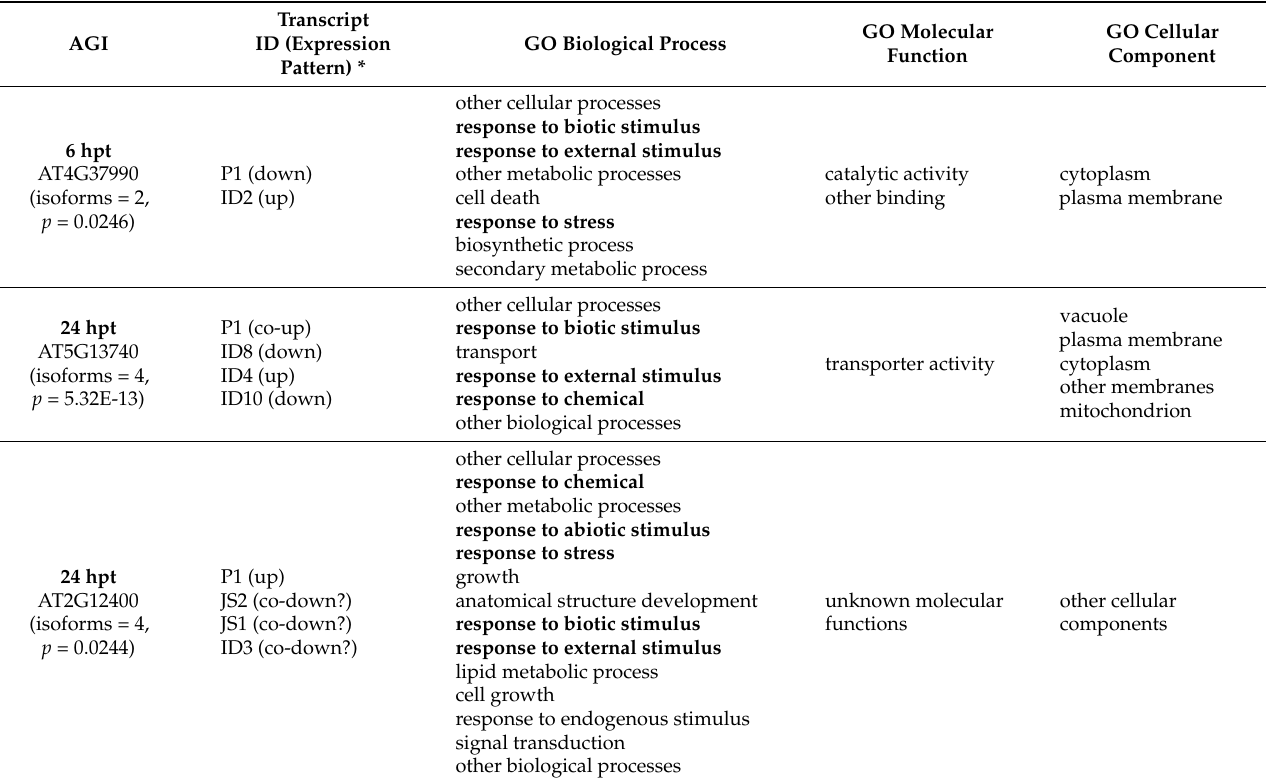
Table 2. Functional categorization of biotic stimulus-response DEGs with isoforms at 6 and 24